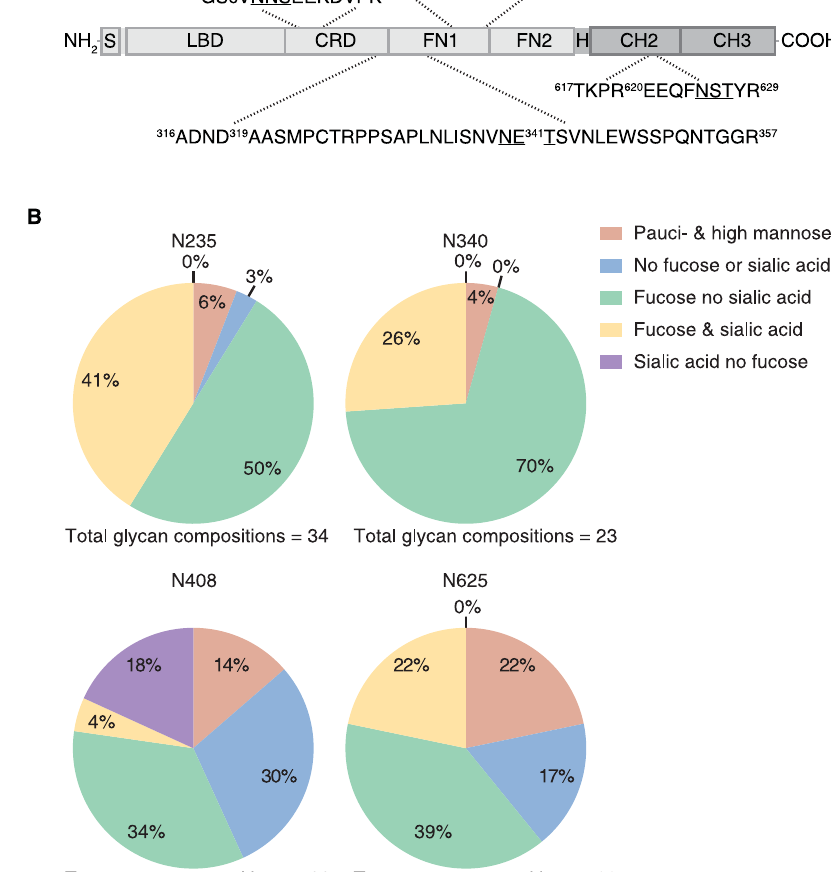
Figure 1. Glycosylation of wild type EphA4 Fc. ( A ) A schematic of EphA4 Fc (not to scale) identifying the EphA4 region (light grey) and the Fc region (dark grey). The EphA4 signal peptide (S) is located at the N-terminus of the protein and is followed by the ligand-binding domain (LBD), cysteine-rich domain (CRD) and two fibronectin type III repeats (FN1) and (FN2) 4 . The IgG4 Fc portion of the protein includes the hinge (H) region and the C H 2 and C H 3 constant immunoglobulin domains. Observed tryptic peptides containing the four N-linked sites (N235, N340, N408 and N625) are displayed with the N-linked consensus sites underlined. The amino- and carboxyl-terminal residues of the tryptic peptides have been annotated with the respective amino acid numbers from the EphA4 Fc sequence. Any additional observed proteolytic cleavage by trypsin or Glu-C within the tryptic peptide sequences have also been annotated with the respective amino acid numbers. ( B ) Qualitative distribution of the glycan compositions observed from EphA4 Fc at N-linked sites N235, N340, N408 and